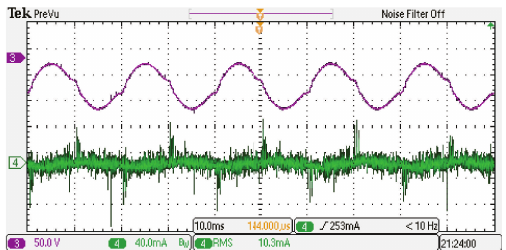
Figure 8: Experimental results of parasitic capacitor voltage and leakage